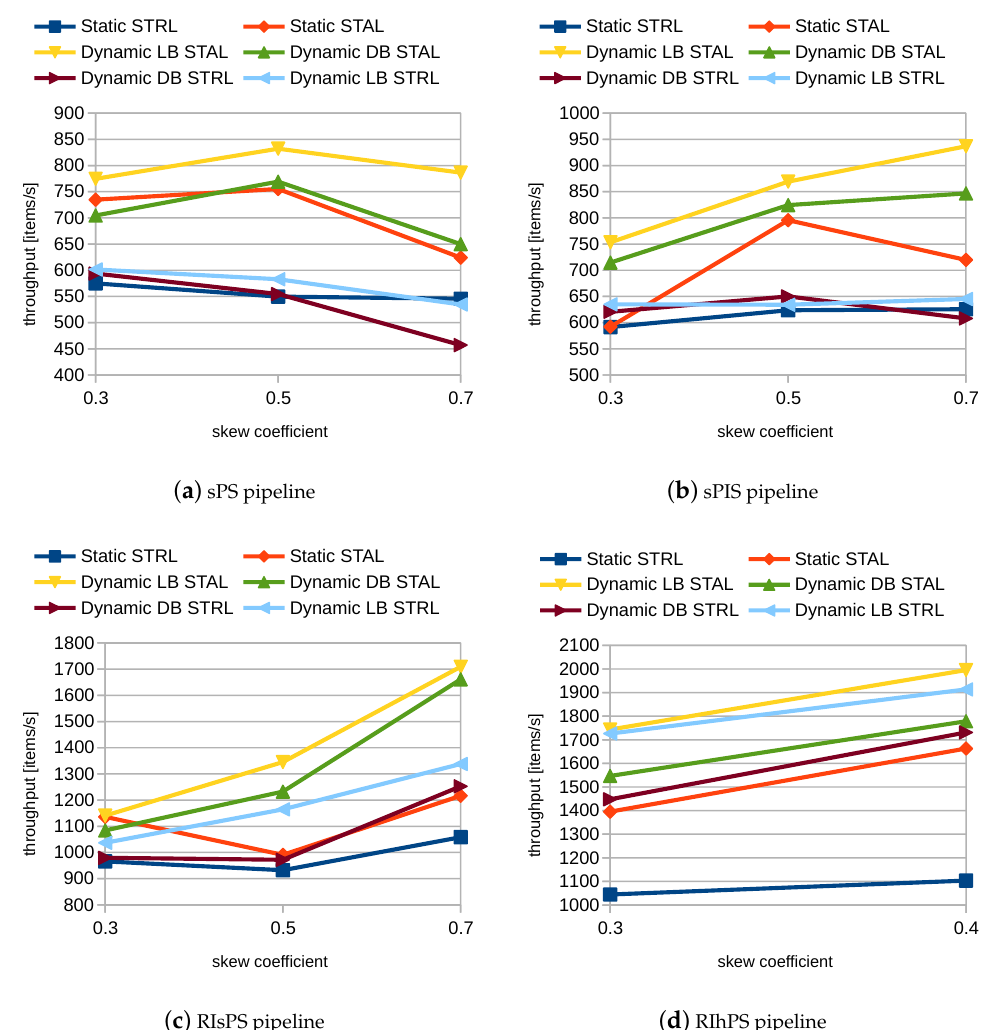
Figure 4. Average throughput against skew coefficient for different modes and